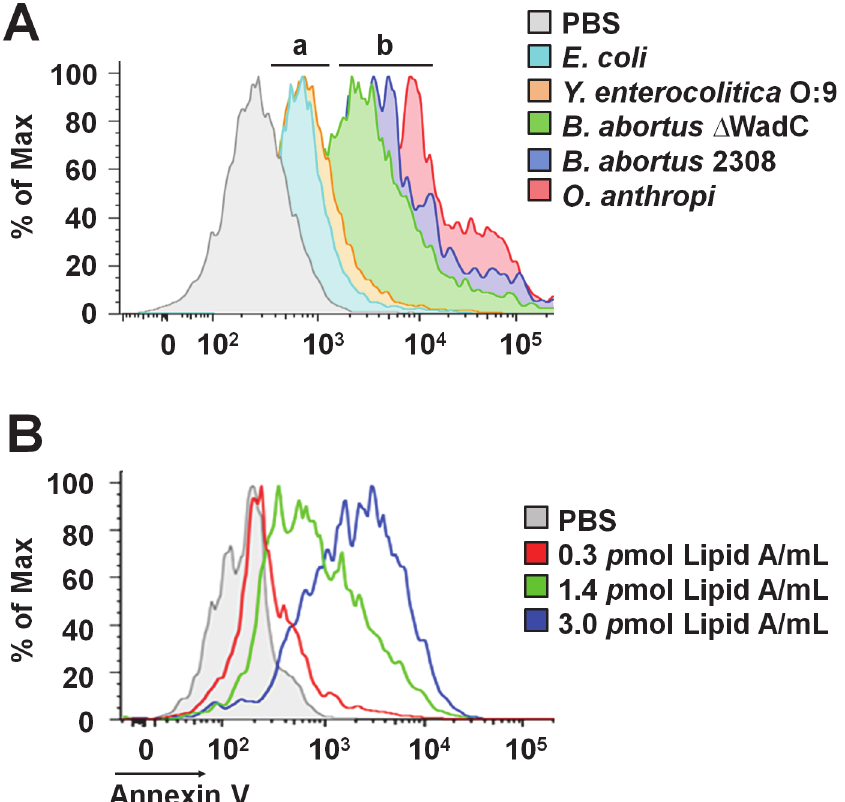
2308 (3 pmol/mL), of B . abortus Δ WadC (3 pmol/mL) and of O . anthropi (2 pmol/mL), all corresponding to 100 μ g/mL of LPS. The LPSs differed in at least one of the moieties (O-chain, core and lipid A) with B . abortus 2308 LPS: (a) LPSs possessing lipid As that differ from B . abortus 2308 LPS, (b) LPSs possessing lipid As structures similar to B . abortus 2308 LPS. (B) Heparinized blood treated with different concentrations of B . abortus 2308 lipid A for two hours. In all assays, PMN population was gated and analyzed by Annexin V marker and the geometric means of histograms displayed as relative units. Experiments were repeated at least three